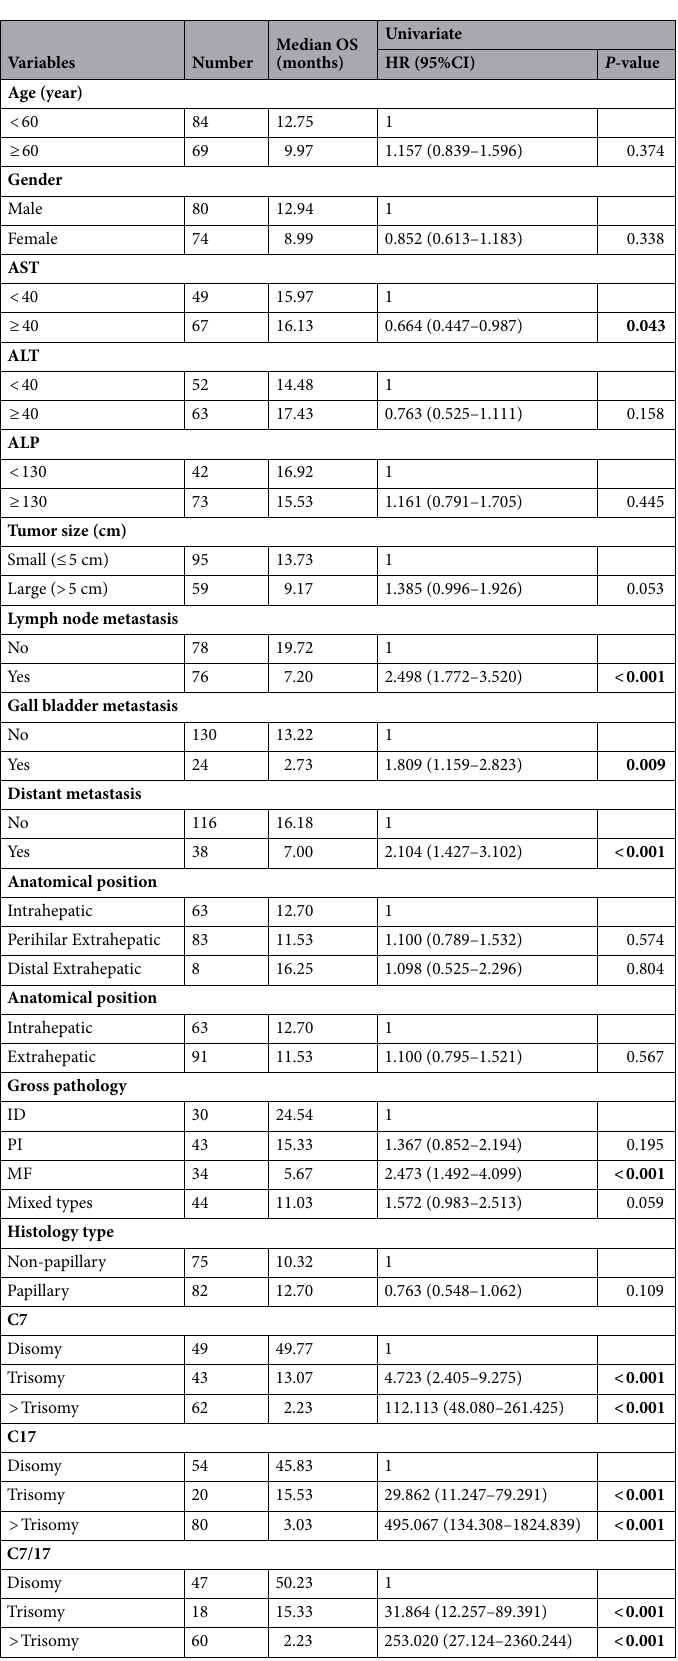
Table 5. Univariate of clinicopathological parameters, chromosomal aberrations and overall survival